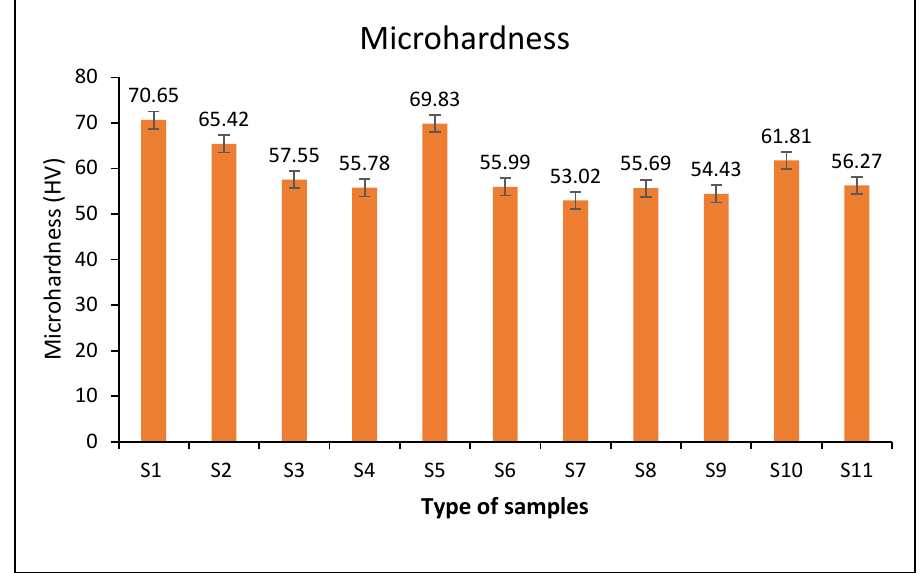
Figure 5. Microhardness of recycled hybrid materials with reinforced B 4 C and ZrO 2 particles.